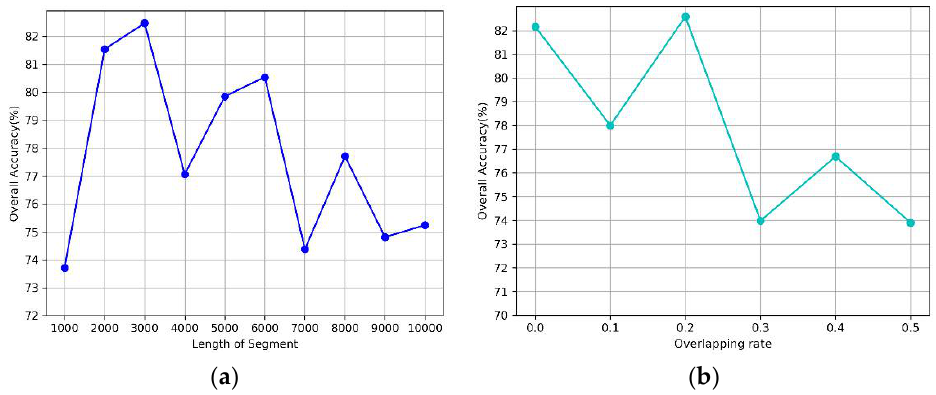
Figure 6. The impact of input segment on performance. ( a ) the length, ( b ) the overlapping rate.